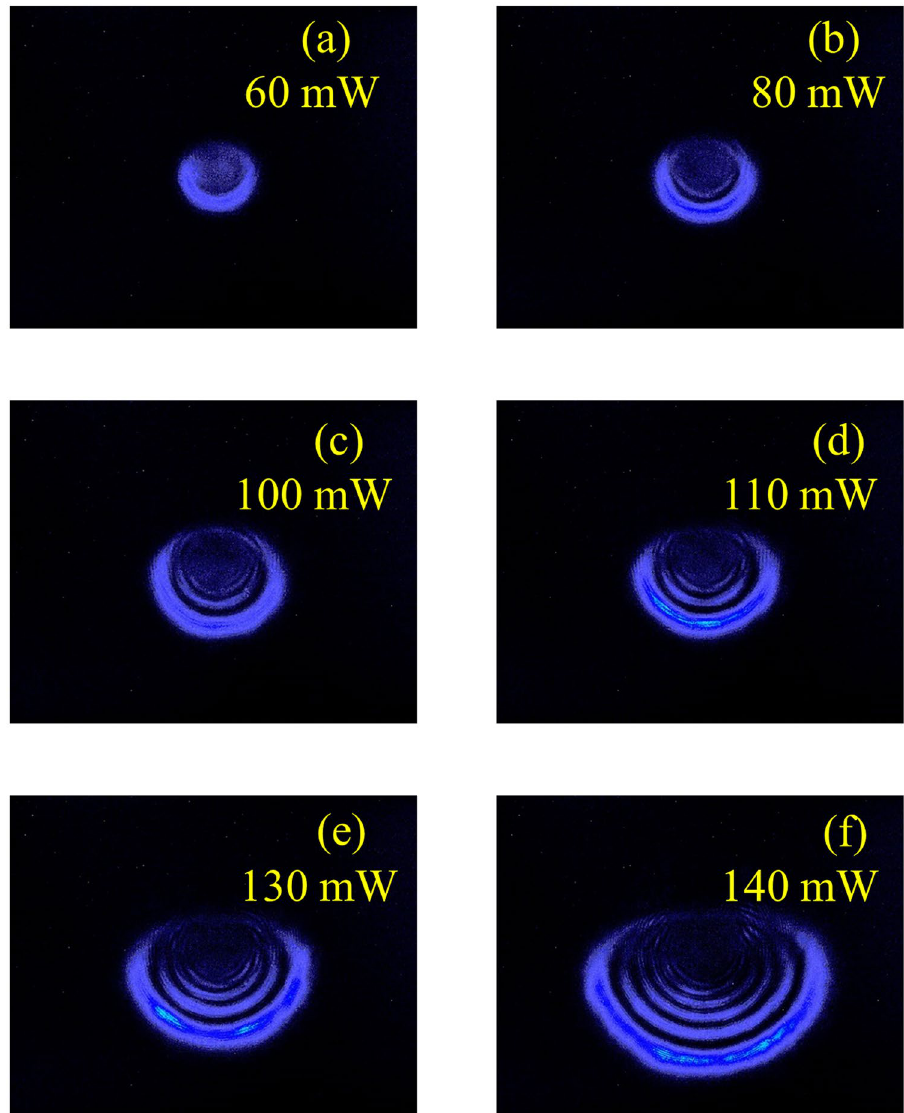
Figure 5. BP solution dispersions (~7.5 Vol.%) under input laser power increasing gradually from ( a ) to ( f ) as ( a ) 60, ( b ) 80, ( c ) 100 ( d ) 110, ( e ) 130 and ( f ) 140 mW,